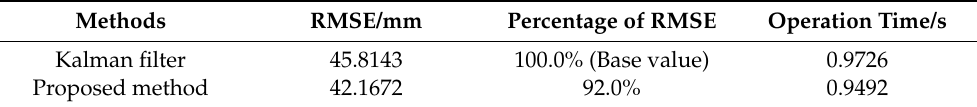
Table 7. Comparison results between the proposed method and the Kalman